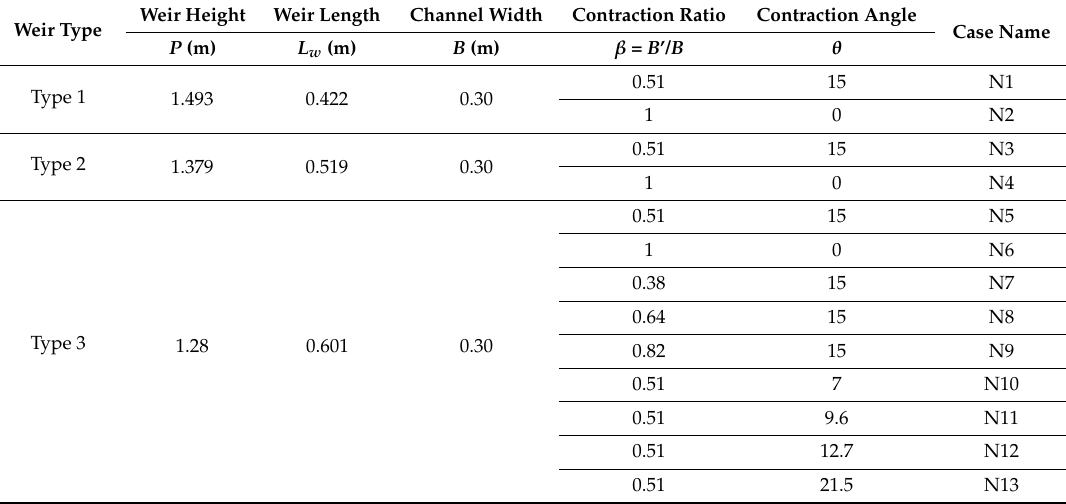
Figure 2. Definition sketch of the finite-crest length weir with FGP (Flaring Gate Pier): ( a ) plane view; ( b ) front view; ( c ) side view ( L w —the length of the weir, L p —the length of the FGP, B —the width of the weir crest, b —the width of the weir outlet, P —the height of the weir, H —the head of the weir, V 0 —approching velocity). Table 1. Parameters of the finite-crest length weir and FGP.